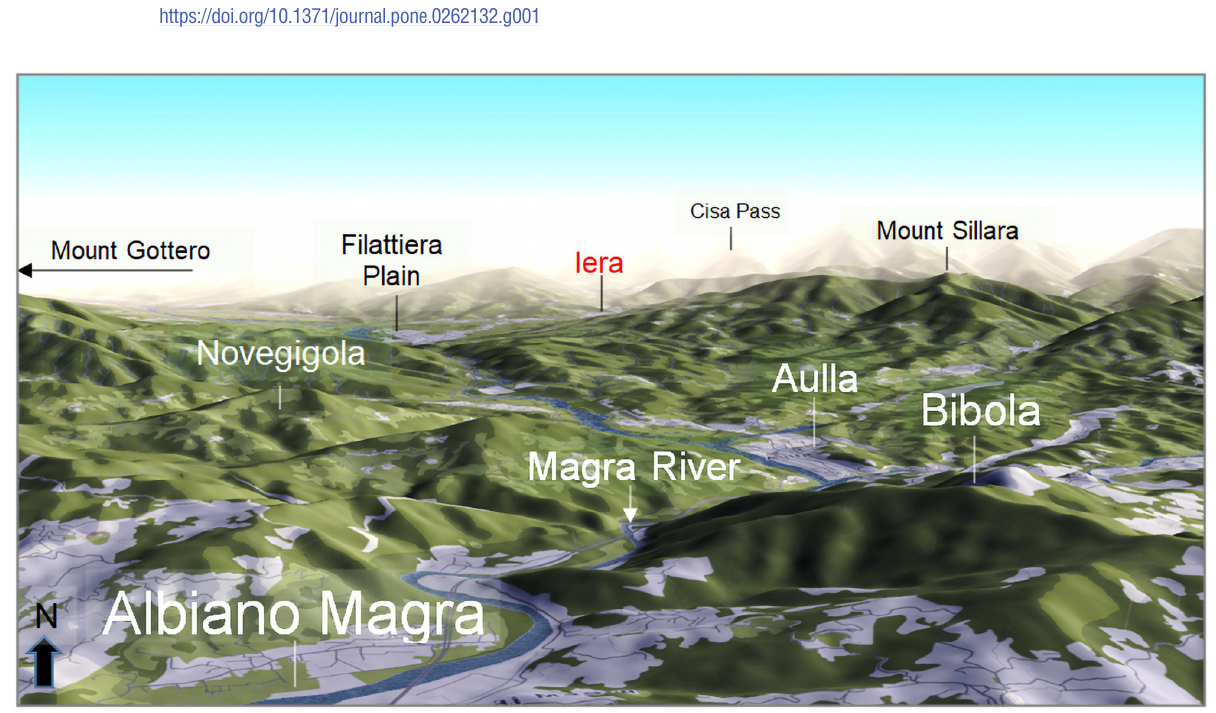
Fig 2. Perspective view of the Magra landscape. The Magra River crosses the valley from north to south passing through the borough of Novegigola (commune of Tresana, 44˚ 14 0 N, 09˚ 57 0 E), and the city of Aulla (44˚ 13 0 N, 09˚ 58 0 E) and its fractions Albiano Magro and Bibola. The site of Iera (commune of Bagnone, 44˚ 18 0 N, 09˚ 59 0 E), which is the reference rainfall station for this study, is marked in red. The highest elevations are also indicated. Map is an output image created from OpenStreetMap (https://demo.f4map.com/#camera.theta=0.9).